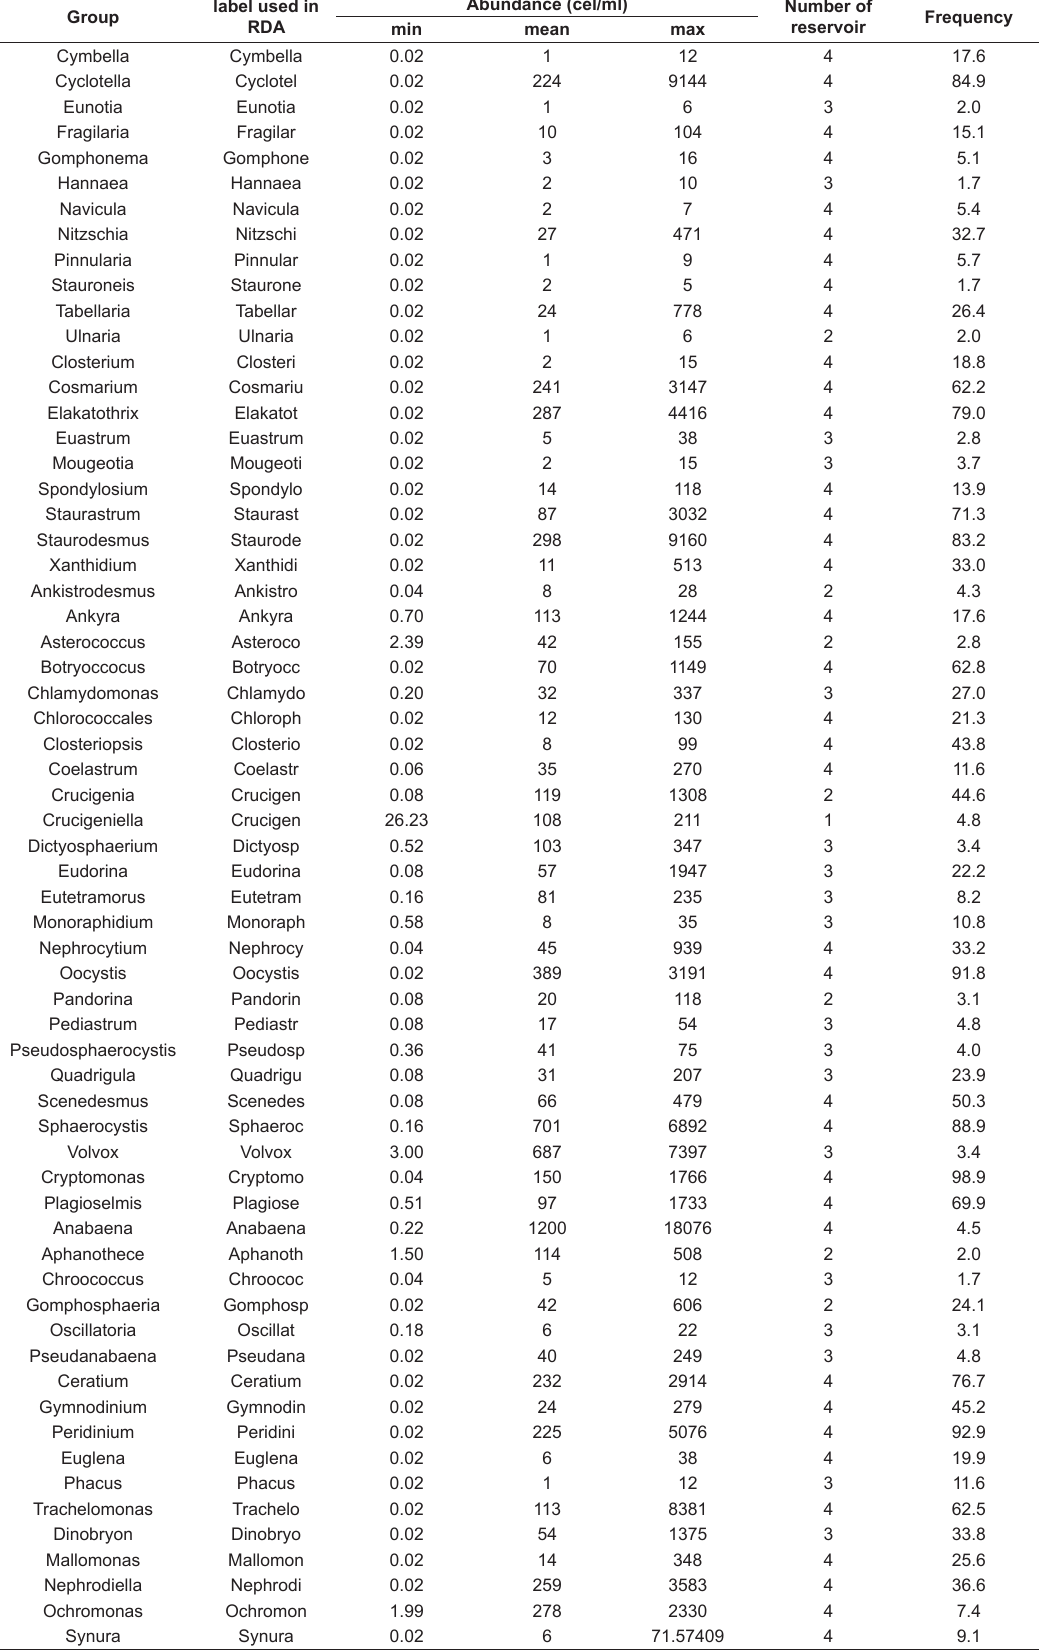
Table 4. Summary of the abundance of the groups of Genera ( sensu lato ) found in the